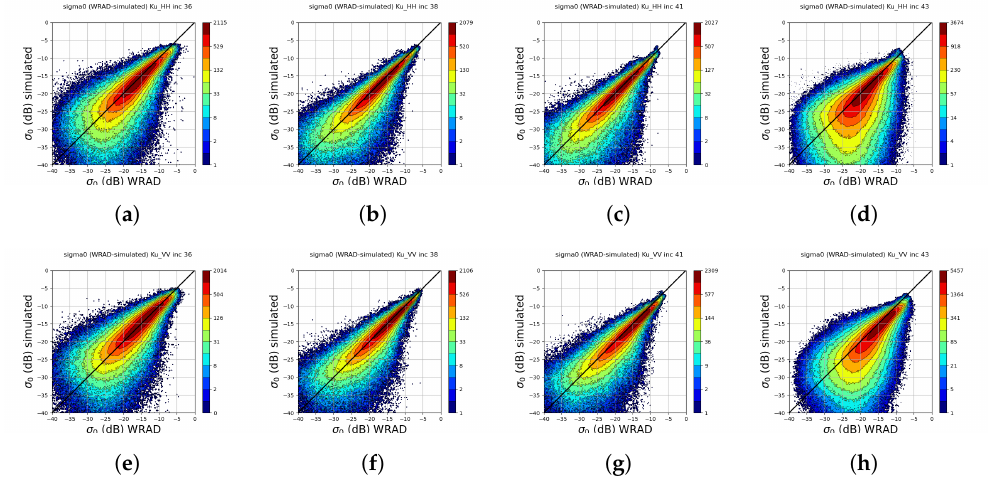
Figure 5. Joint distribution of Ku-band measured σ ° and simulated σ °, ascending orbits, date 1 November 2022–3 November 2022, HH (upper panel), VV (lower panel): ( a , e ) incidence angle 36°;